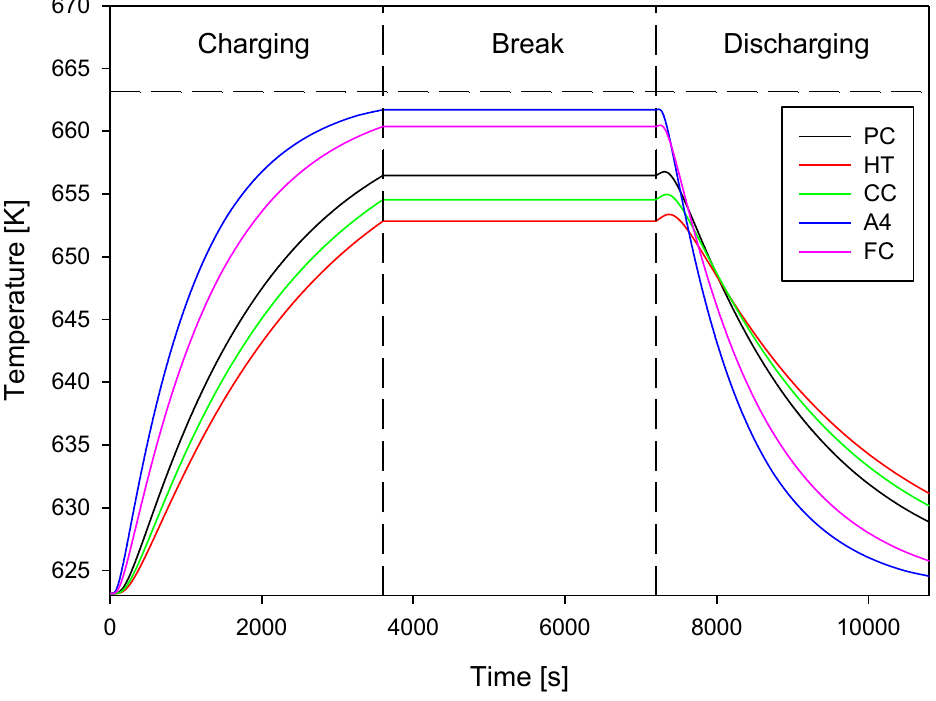
Figure 6. Temperature contour maps at constant V